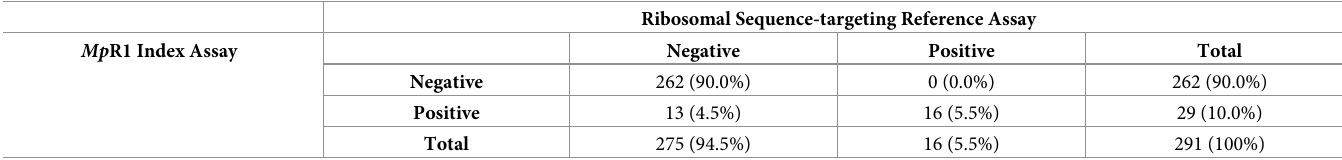
Table 3. Agreement of assay results upon comparative testing of field-collected mosquito